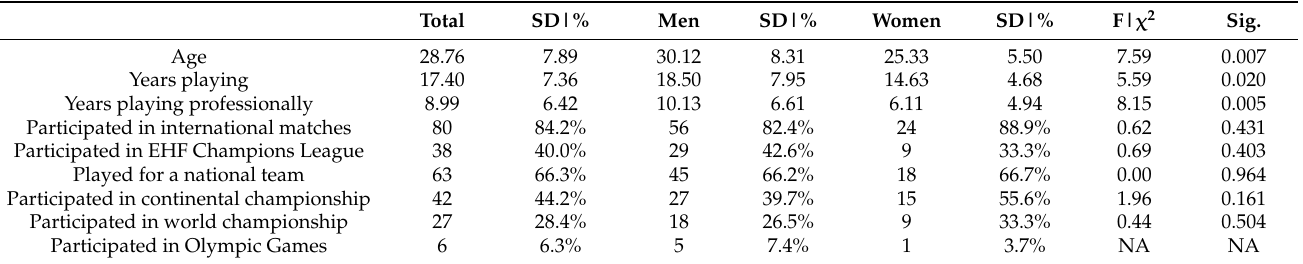
Table 1. Means and frequencies for career background questions and comparisons between male and female respondents.